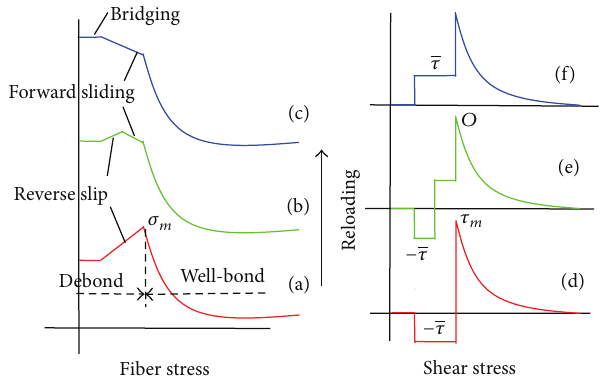
Figure 11: Stress transfer model of bridging fiber under